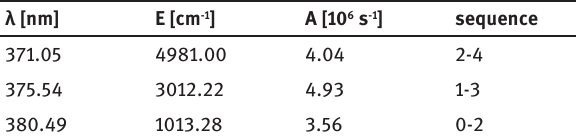
Table 2 : List and characteristics of the nitrogen unresolved band heads used in determining the vibrational temperature using a